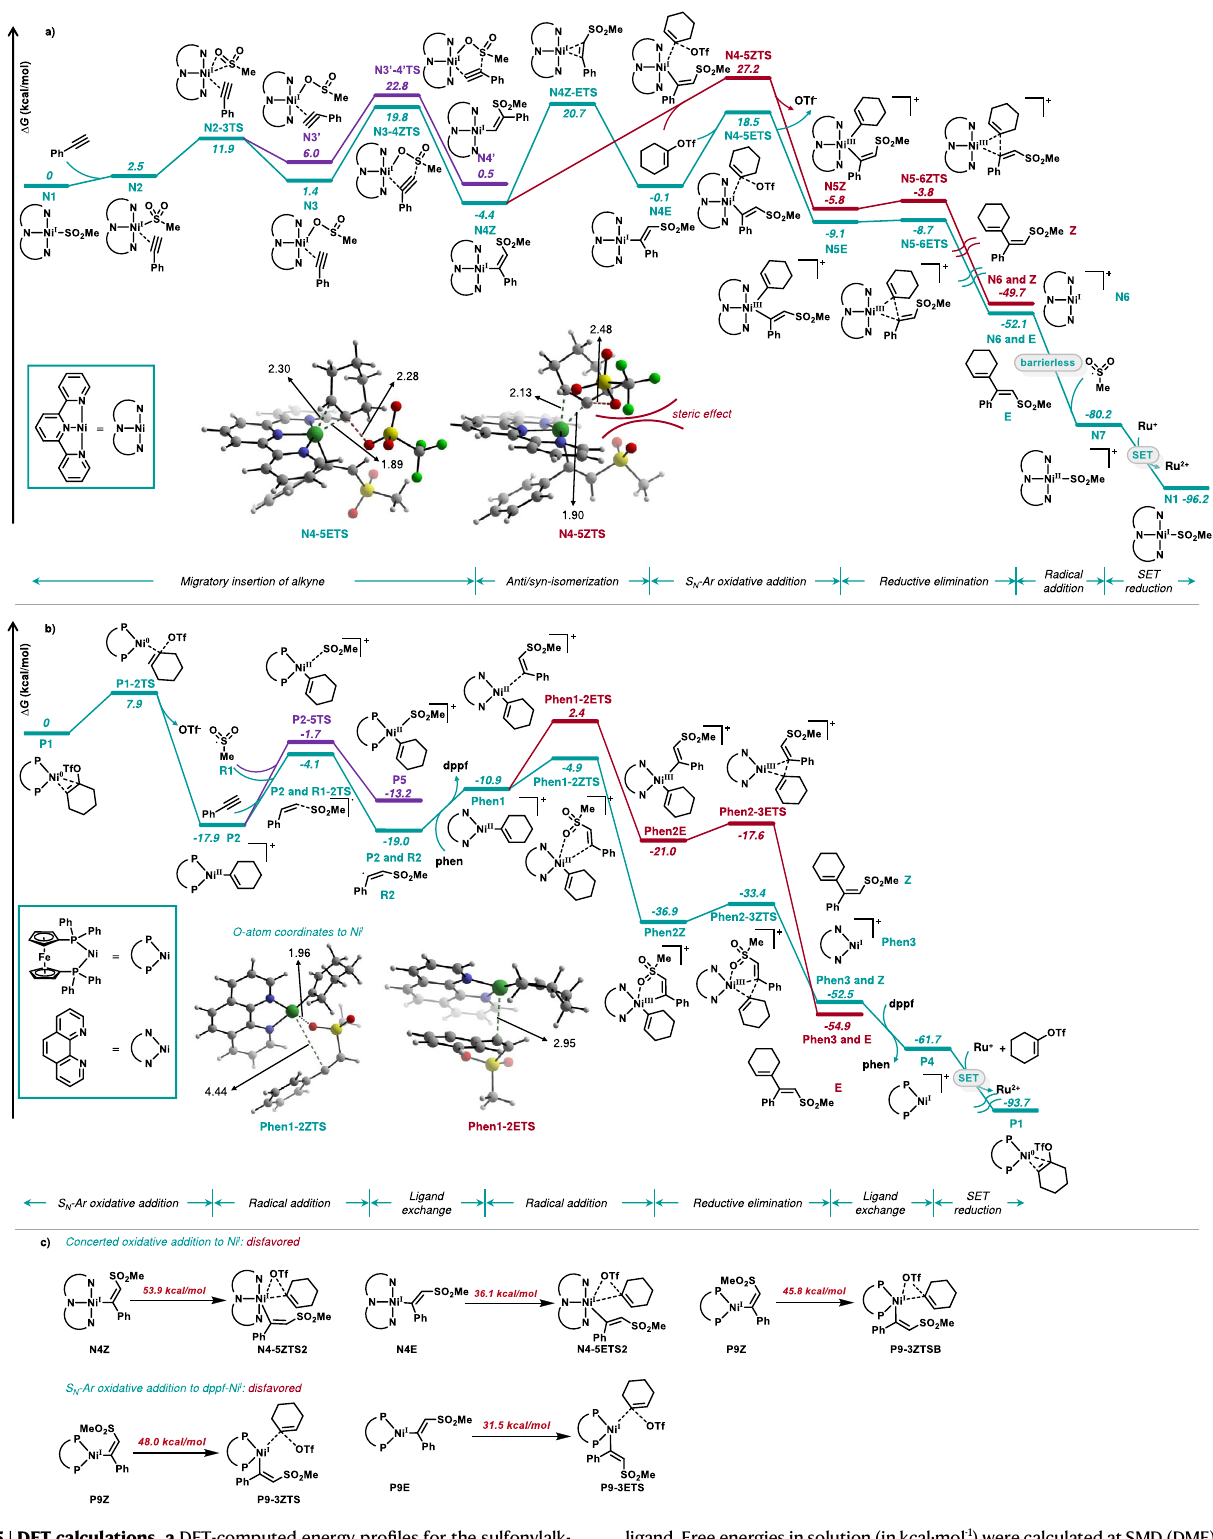
ligand.Freeenergiesinsolution(inkcal·mol -1 )werecalculatedatSMD(DMF)-M06/ Def2-TZVPP//PBE-D3(BJ)/Def2-TZVP (Ni, Fe, Ru)/Def2-SVP (other atoms). DFT- optimized geometries of selected transition states or intermediates are shown. Bond lengths are in